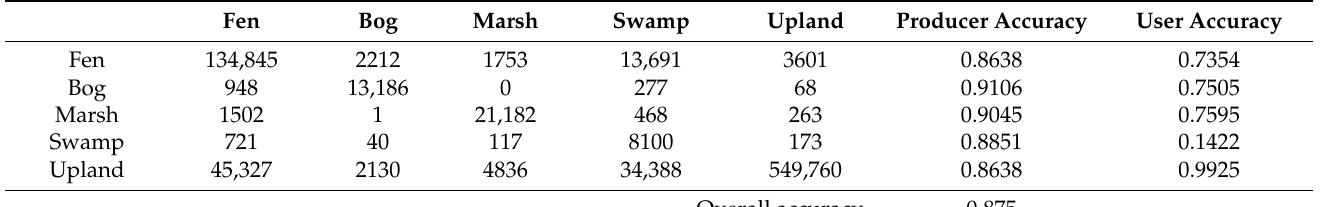
Table 5. Confusion matrix of the traditional method (Classifier #1). Rows represent the classification, while columns represent the reference.